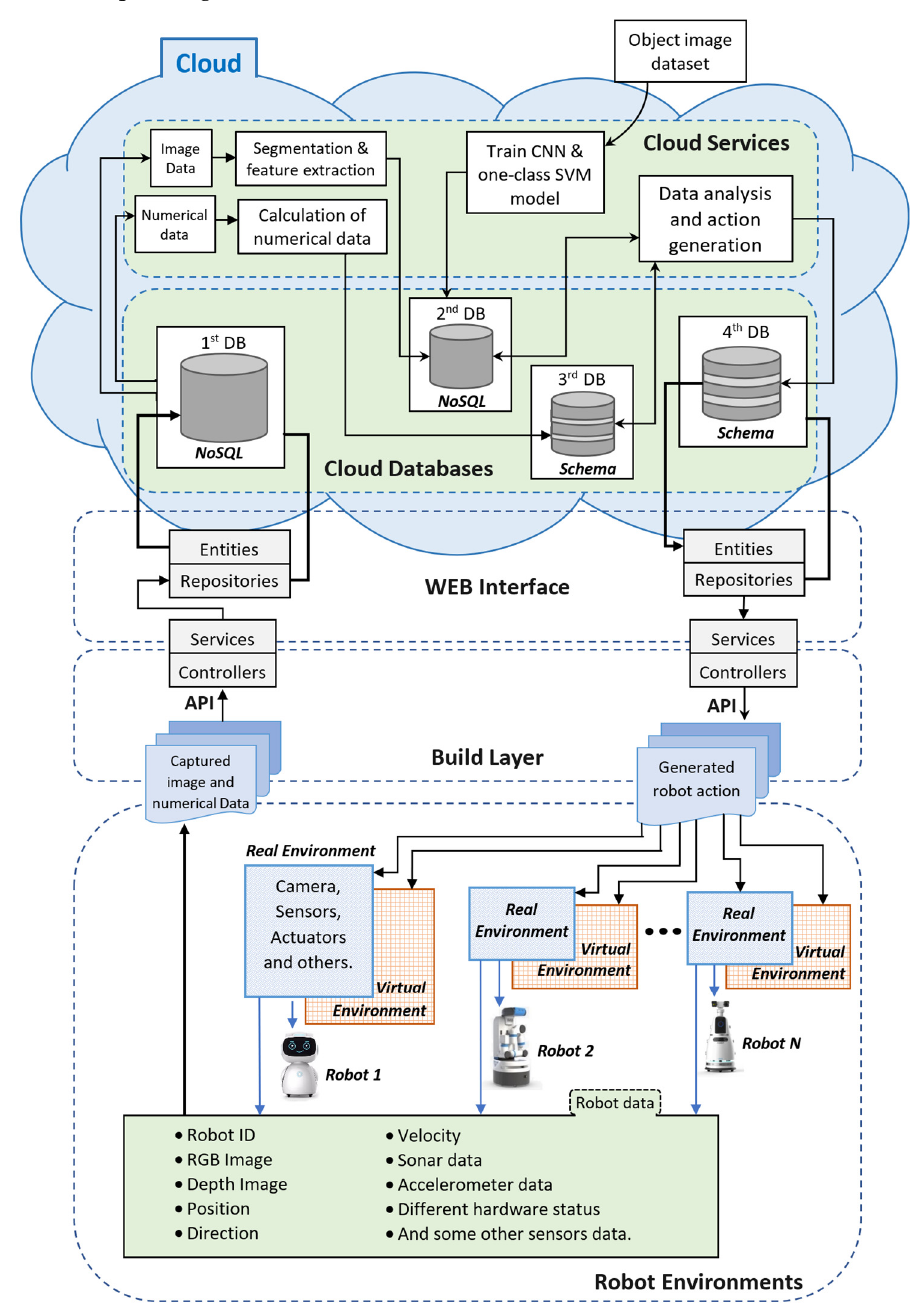
Figure 7. Block diagram of proposed cloud-based architecture.